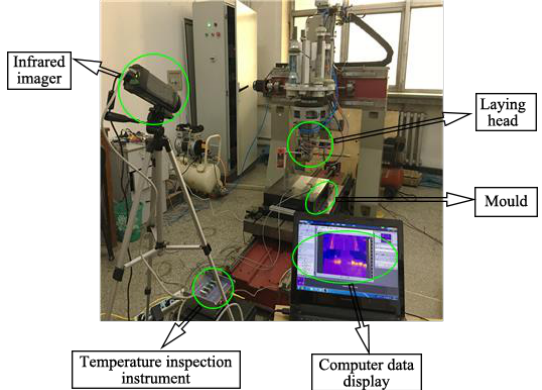
Figure 10. Physical diagram of the online temperature field measurement system.